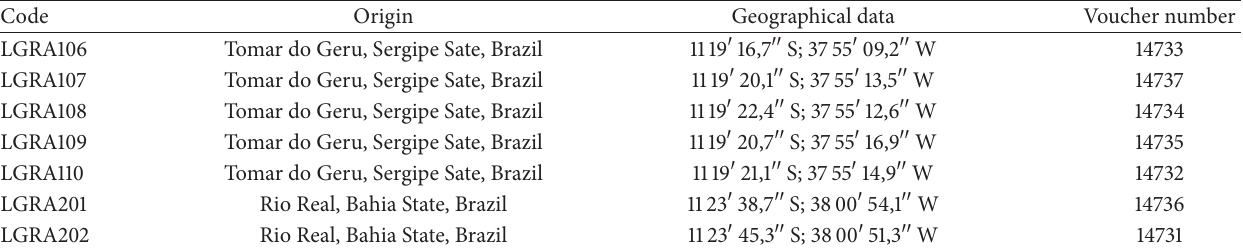
Table 1: Genotypes of L. gracilis present in the Active Germplasm Bank of medicinal plants of the Federal University of